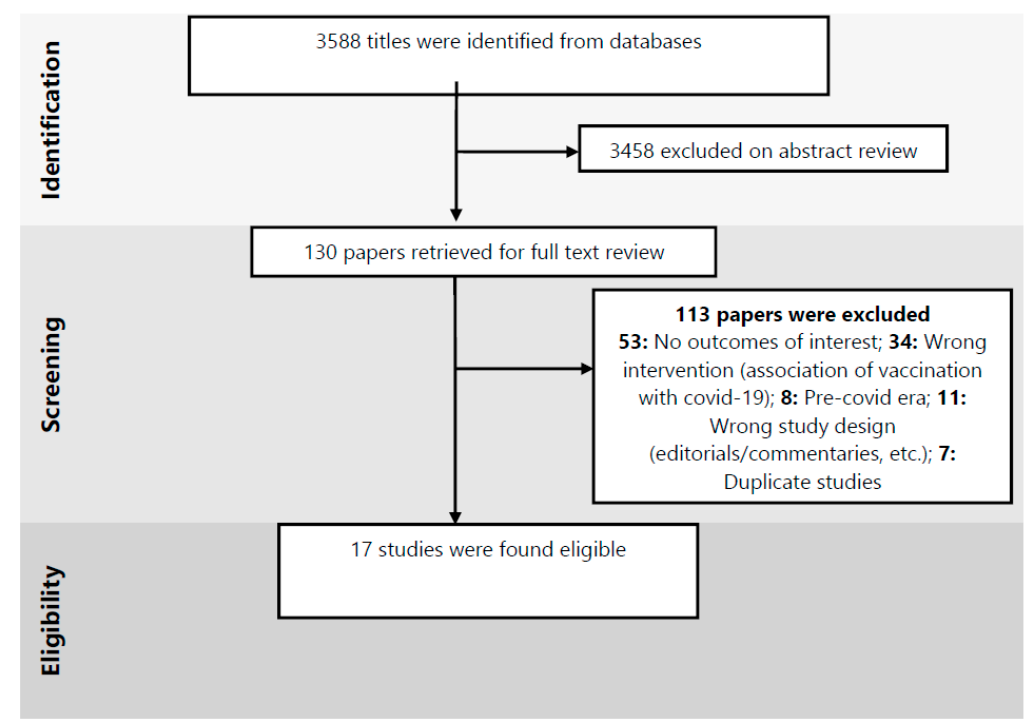
Figure 1. Preferred Reporting Items for Systematic Reviews and Meta-Analyses (PRISMA) flow diagram of study selection process. Table 1. Characteristics of studies